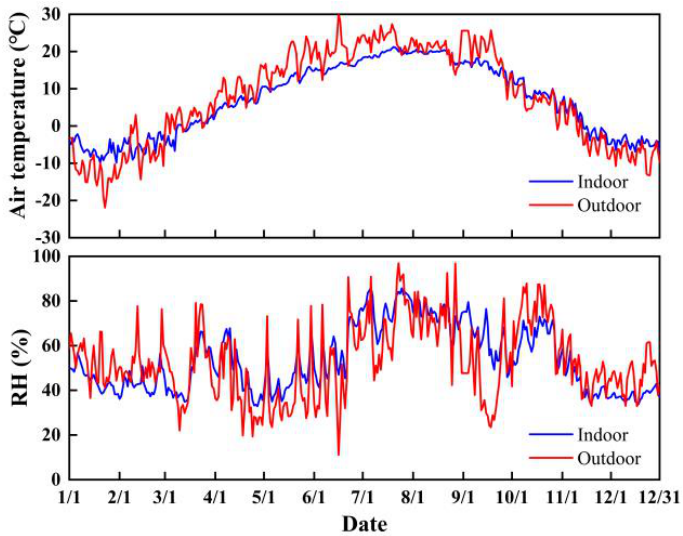
Figure 1. Average daily variations of indoor (Cave 9) and outdoor air temperature and RH in the Yungang Grottoes during 2017.